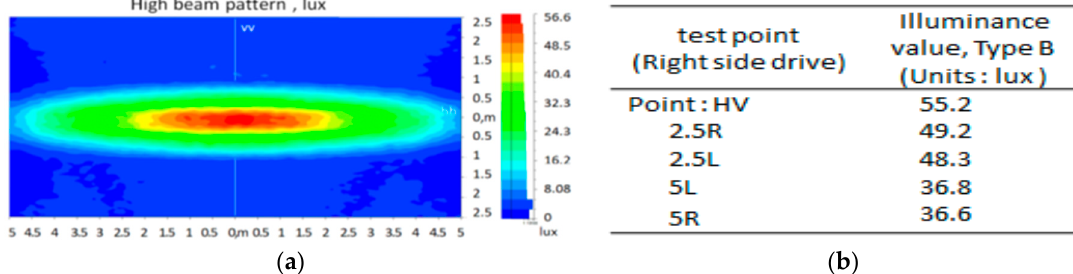
Figure 8. ( a , b ) Simulation results of the high-beam pattern and experimental results. X and Y axis is the meter. Colors indicate the light intensity via Lux. This center of lighting delivers most powerful lux. Relatively high value of illuminance might be eliminated by control of laser output power.